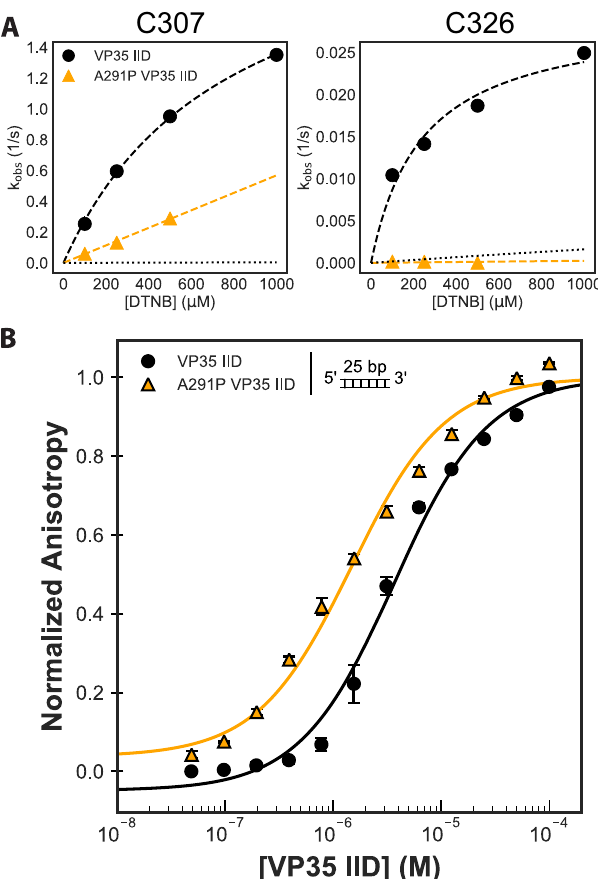
Fig. 5 An A291P mutation favors both the closed cryptic pocket in VP35 ’ s IID and increases dsRNA binding. A DTNB observed labeling rates of both wild-type and the A291P mutation for the two cysteines in the pocket. All four cysteines are present, complete data for all four observed rates are in Supplemental Fig. 4. B Binding of both C247S/C275S and A291P VP35 IID to a fl uorescently labeled 25-bp double-stranded RNA. The anisotropy was calculated from measured fl uorescence polarization and fi t to a single-site binding model (black and orange lines). The means and standard deviations from three replicates are shown but error bars are generally smaller than the symbols. Anisotropy was normalized to the max anisotropy for each dataset. Source data are provided as a Source Data fi